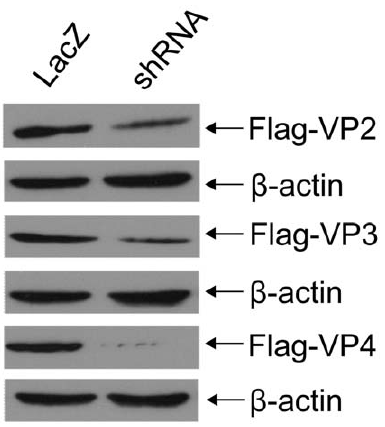
Figure 1. shRNAs silencing transient expression of viral genes in 293T cells. Cell lysates of 293T cells co-transfected with shRNA recombinant lentivirus vectors and either pcDNA3-Flag-VP2, pcDNA3- Flag-VP3, or pcDNA3-Flag-VP4 were separated by SDS-PAGE, and then analyzed by Western blotting using antibodies against Flag and b -actin. Three experiments were independently